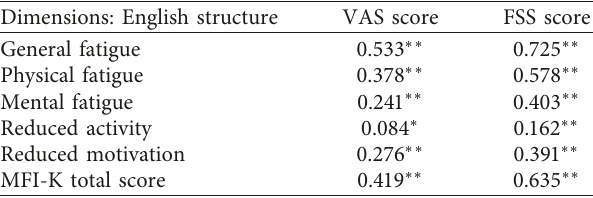
Table 4: Correlation between MFI-K and VAS score and FSS score in English factor structure.